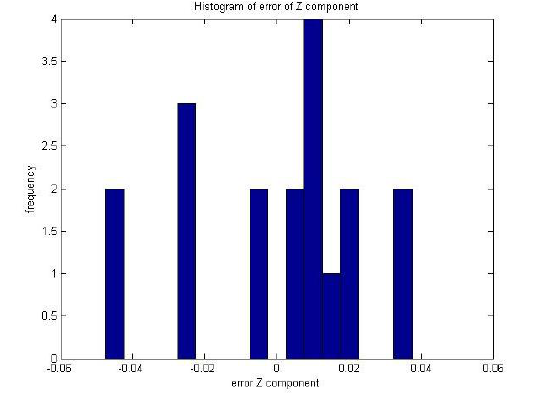
Figure 6. Histogram of the errors